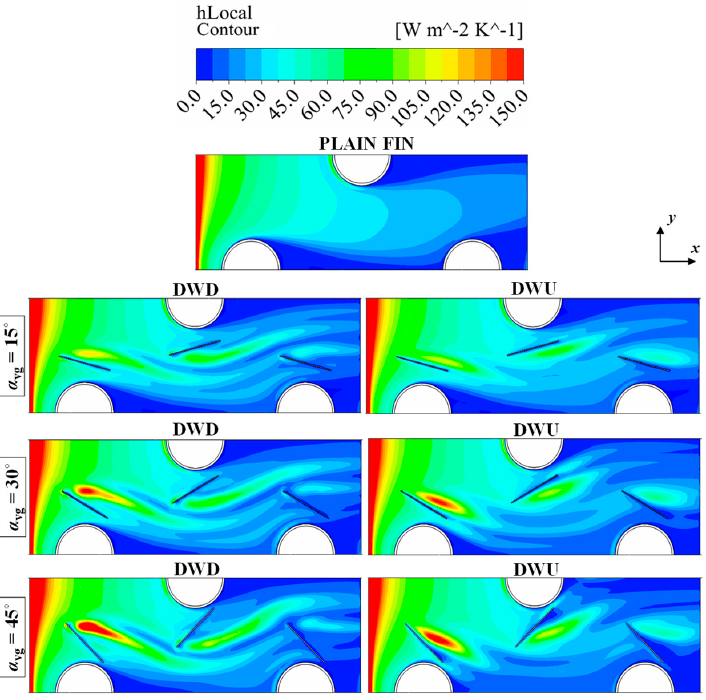
Figure 15. Distributions of the local air − side heat transfer coefficients on the plain fin surface and lower fin surface with mounted vortex generators for air − to − water FTHEXs with DWD and DWU configurations. Test conditions: T air,in = 22 °C, T water,in = 40 °C, w air,in = 1.03 m/s, w water,in = 0.76 m/s.